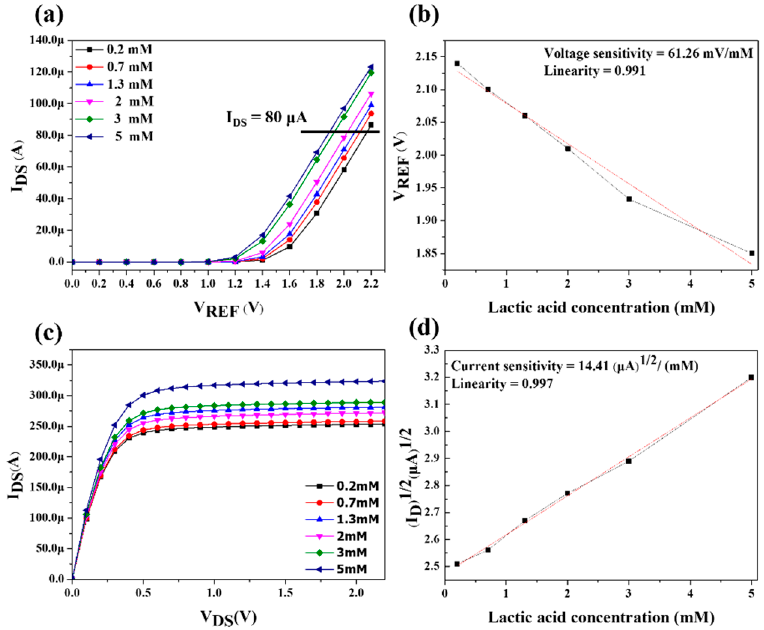
Figure 9. The sensing characteristics of EGFET for LA detection under the static measurement. ( a ) I DS –V REF conversion curve, ( b ) voltage sensitivity when I DS = 80 μ A, ( c ) I DS –V DS transfer curve, and ( d ) current sensitivity.